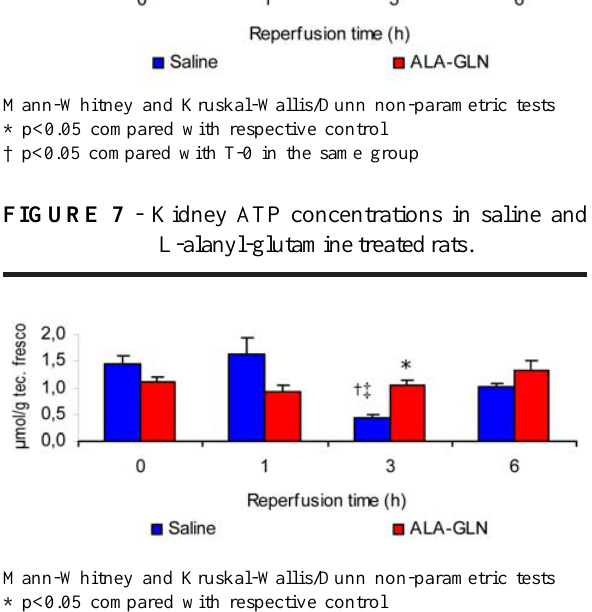
FIGURE 8 - Kidney ketone bodies concentrations in saline and L-alanyl-glutamine treated